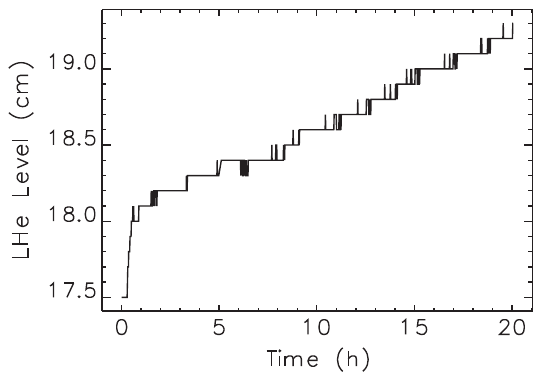
FIG. 9. Measured SCU0 magnet excitation curve.